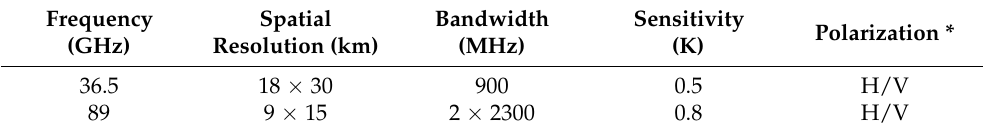
Table 2. Information on the parameters of FY-3D/MWRI